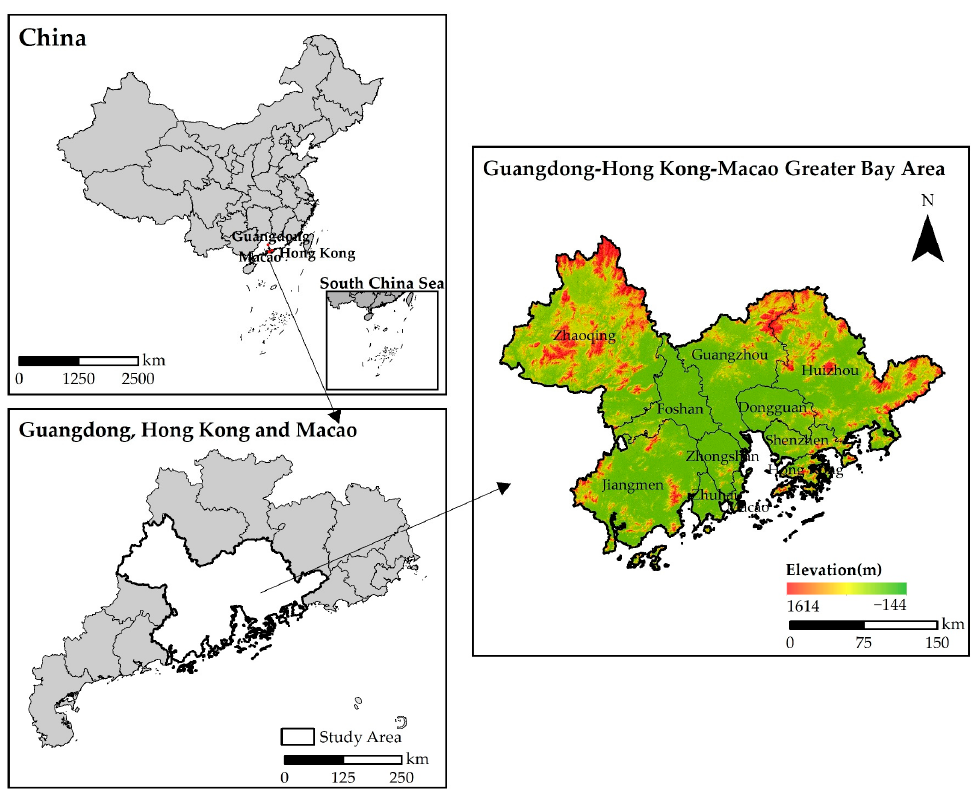
Figure 1. The study area.